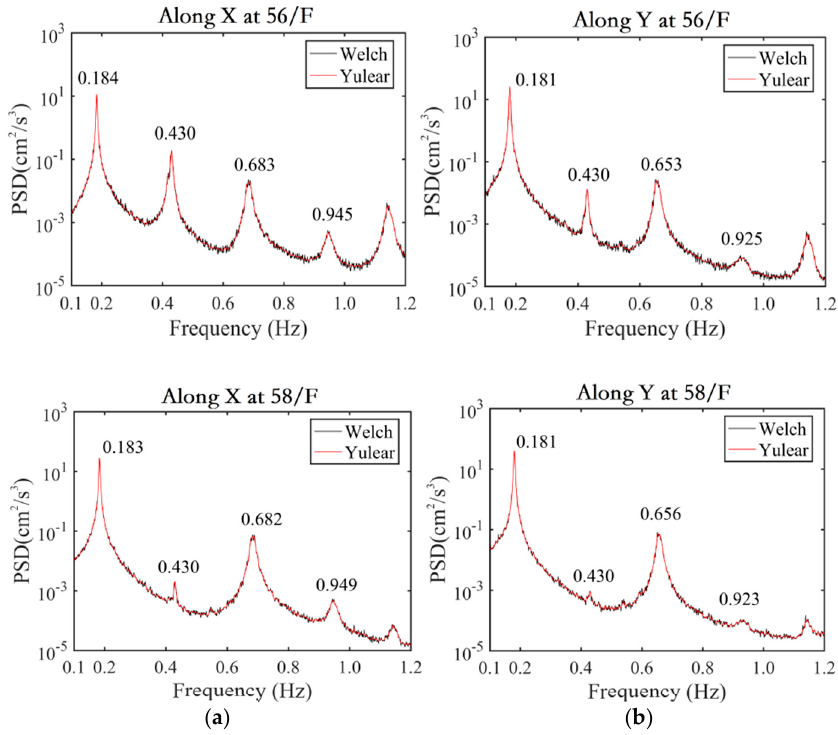
Figure 9. Comparison of power spectral density curves by the Welch and the Yule–Walker methods. ( a ) Along X; ( b ) Along Y.